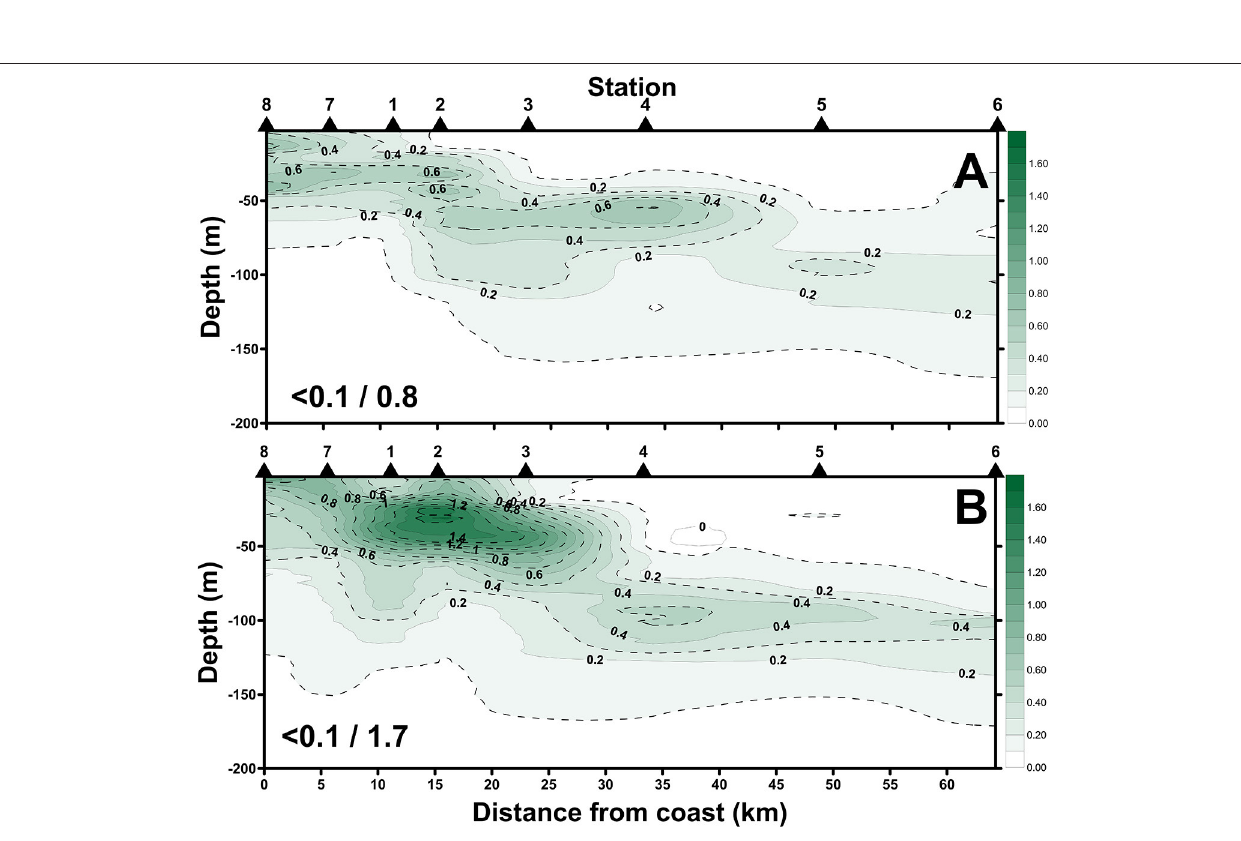
Frontiers in Marine Science |